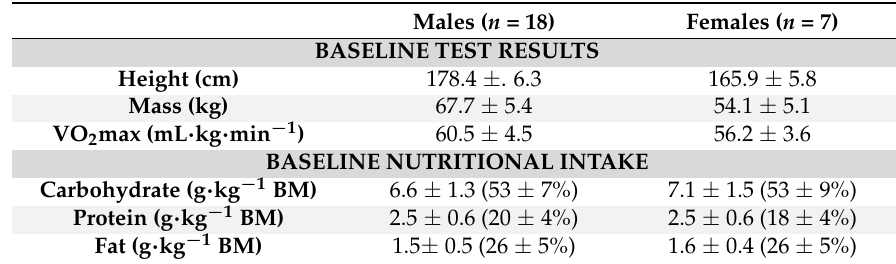
Table 1. Participant characteristics (mean ± SD). Nutritional intake is presented as daily intake relative to body mass (BM), and as a percentage of total energy intake.